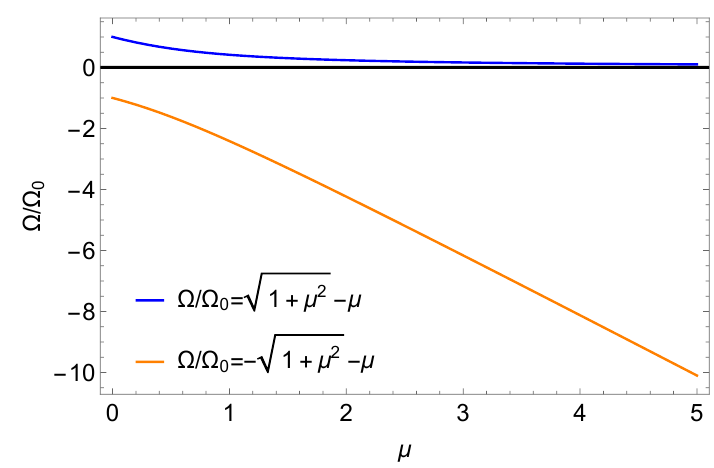
Figure 2: The dispersion of surface waves as a function of odd viscosity at vanishing shear → 0. Here Ω = (cid:112) gk and µ = ν viscosity ν e 0